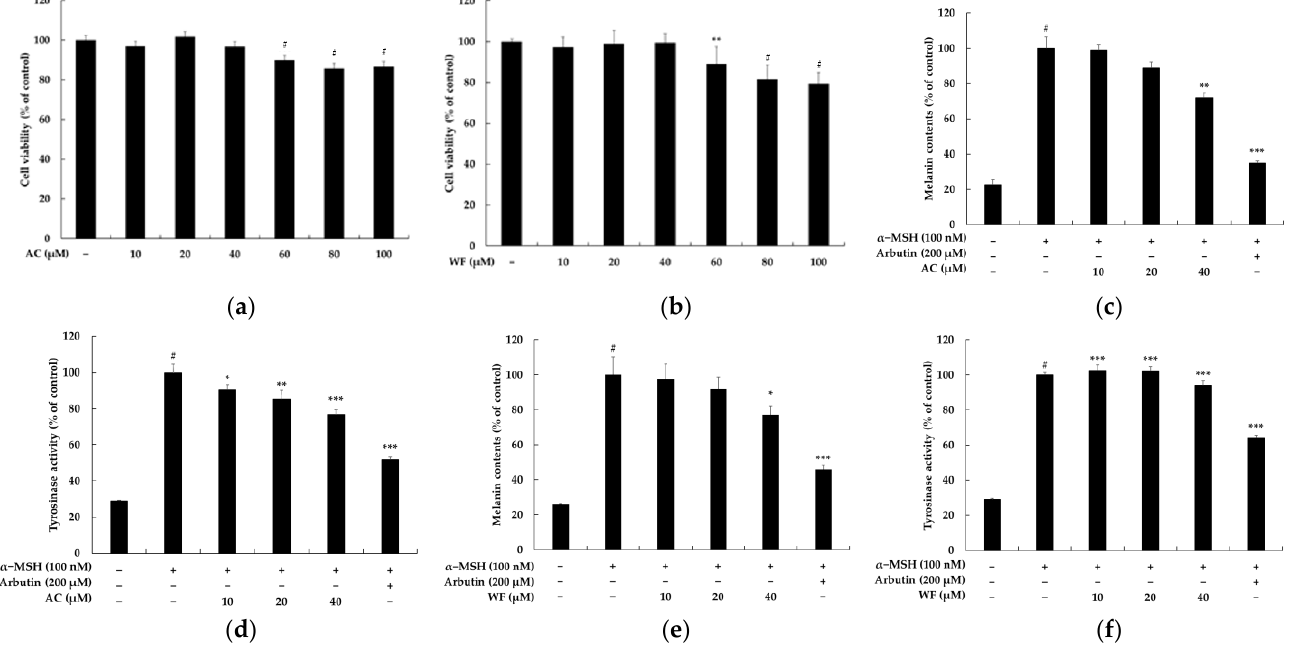
Figure 2. The effect of coumarin derivatives on the viability, melanin contents, and tyrosinase activity in B16F10 melanoma cells. The cells were treated with coumarin derivatives (10, 20, 40, 60, 80 and 100 μM) for 72 h. Cytotoxicity of acenocoumarol ( a , AC) and warfarin ( b , WF) were evaluated using the MTT assay. Cell viability is expressed as percentages relative to untreated cells. The results are presented as the mean ± SD from three repeated experiments. For melanin production and tyrosinase activity, the cells were treated with AC ( c , d ) and WF ( e , f ) for 72 h at 10, 20 and 40 μM concentration. α -MSH was used as the negative control and arbutin (200 μM) was used as the positive control. We conducted three repeated measurements using Image J and present the results as mean ± SD. Statistical significance was expressed as follows: # p < 0.001 vs. unstimulated control group, * p < 0.05, ** p < 0.01, *** p < 0.001 vs. α -MSH alone.